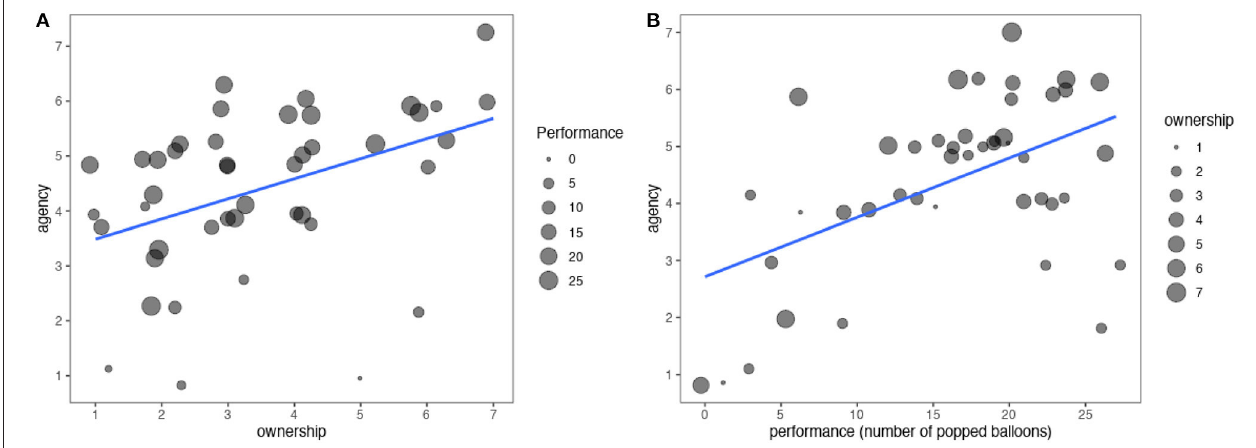
FIGURE 4 | Perceived agency by ownership (A) and performance (B) , the blue lines represent the single factor linear fit. Categorical responses (ownership and agency) are jittered for better visibility.